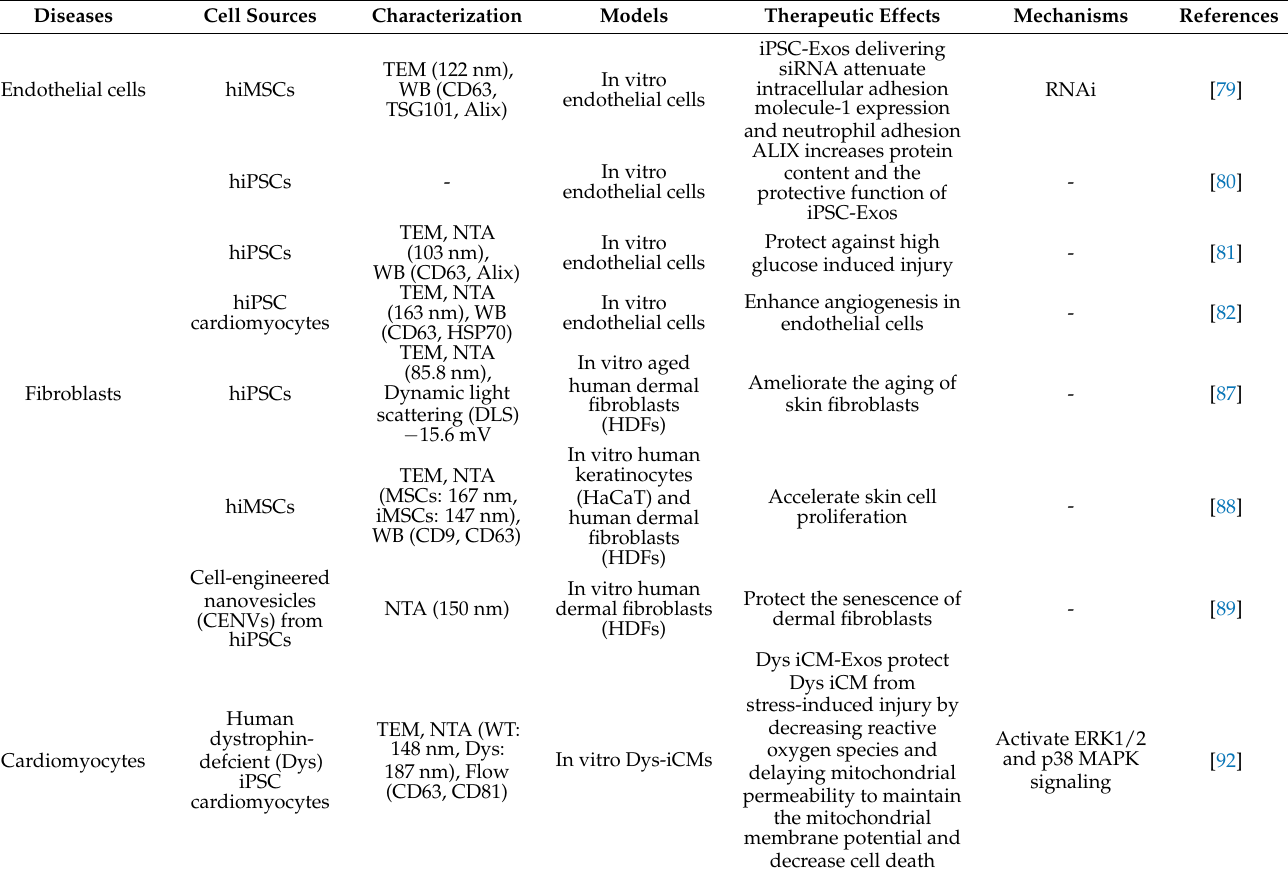
Table 2. Therapeutic effects of induced pluripotent stem cell -derived exosomes on cells in vitro. Diseases Cell Sources Characterization